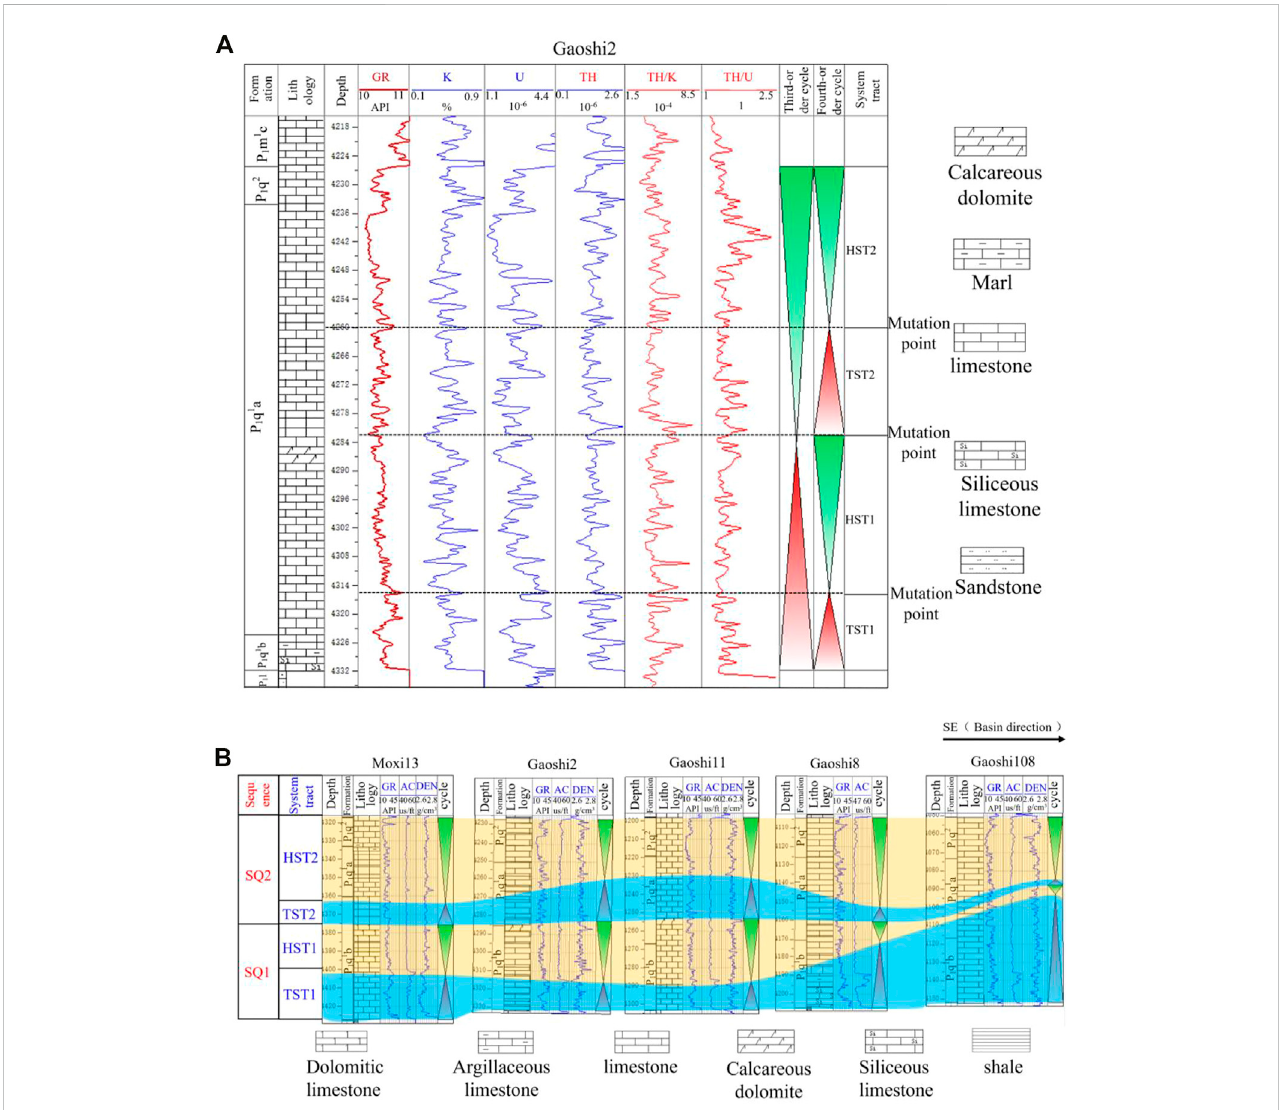
FIGURE 3 (A) Well logging sequence division of well Gaoshi2; (B) Correlation diagram of Qixia Formation systems tract of Moxi13-Gaoshi2-Gaoshi11-Gaoshi8- Gaoshi108 ( ① ) well connection pro fi le. See Figure 1B for the plane position of the well connection correlation